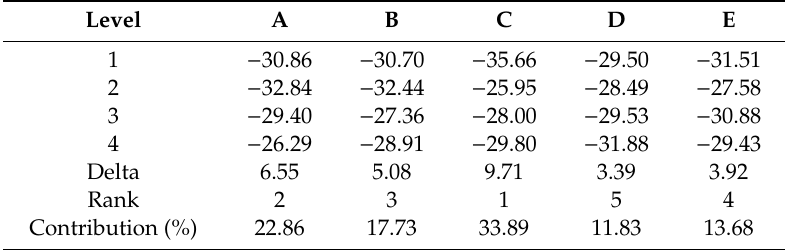
Figure 34. The effect of each design factor on h mass. Table 6. Factorial effect of Fr.